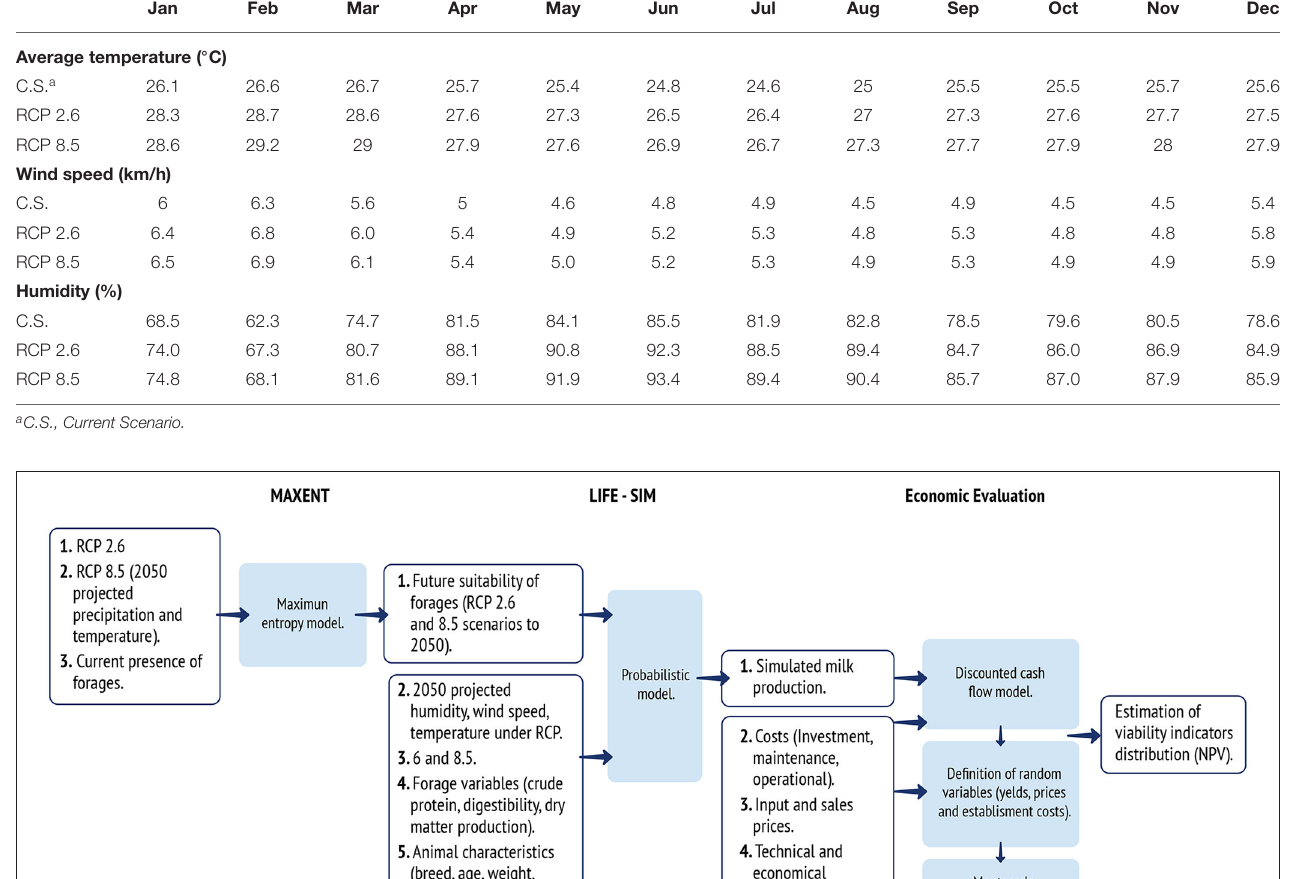
TABLE 4 | LIFE-SIM model inputs–climatic variables. Jan Feb Mar Apr May Jun Jul Aug Sep Oct Nov Dec Average temperature ( ◦ C)